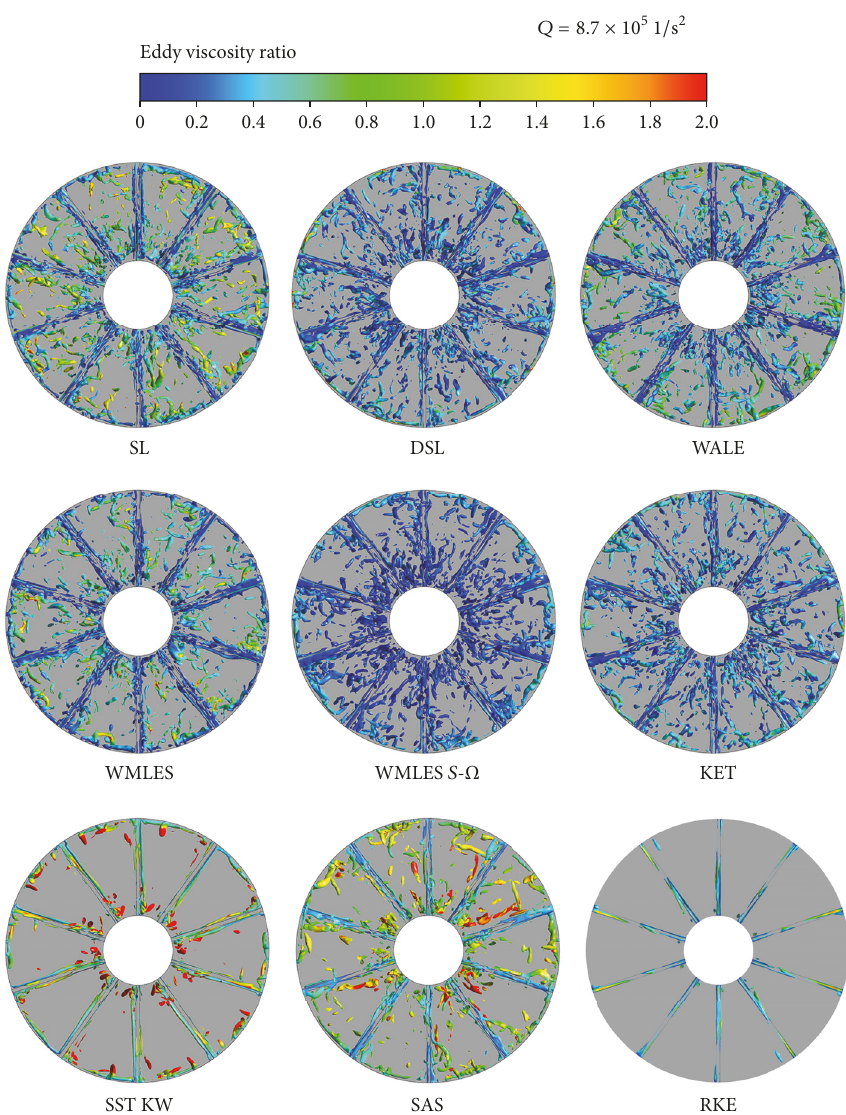
Figure 5: Vortex structures within